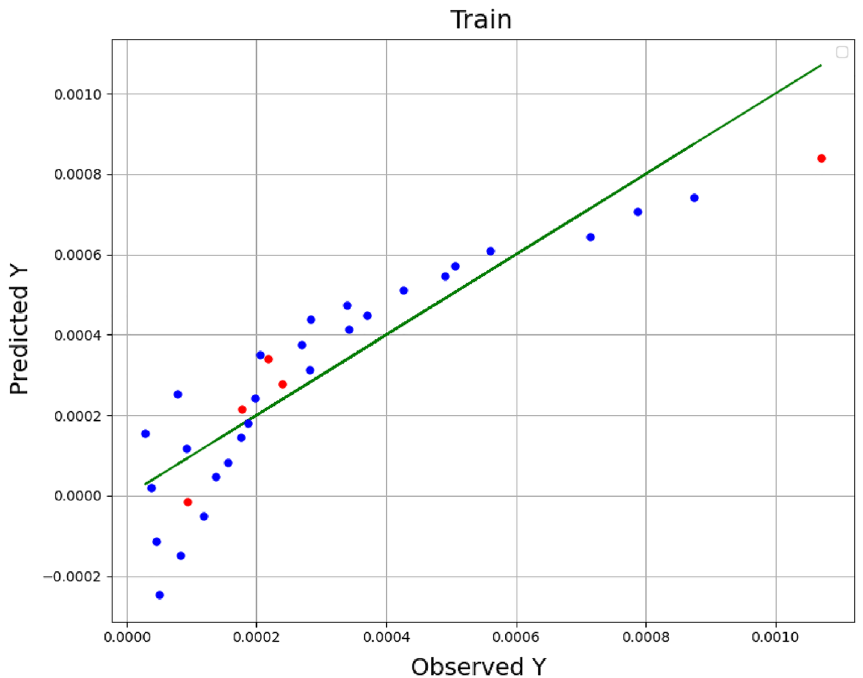
Figure 1. Observed vs estimated values (KRR) (Y: solubility/mole